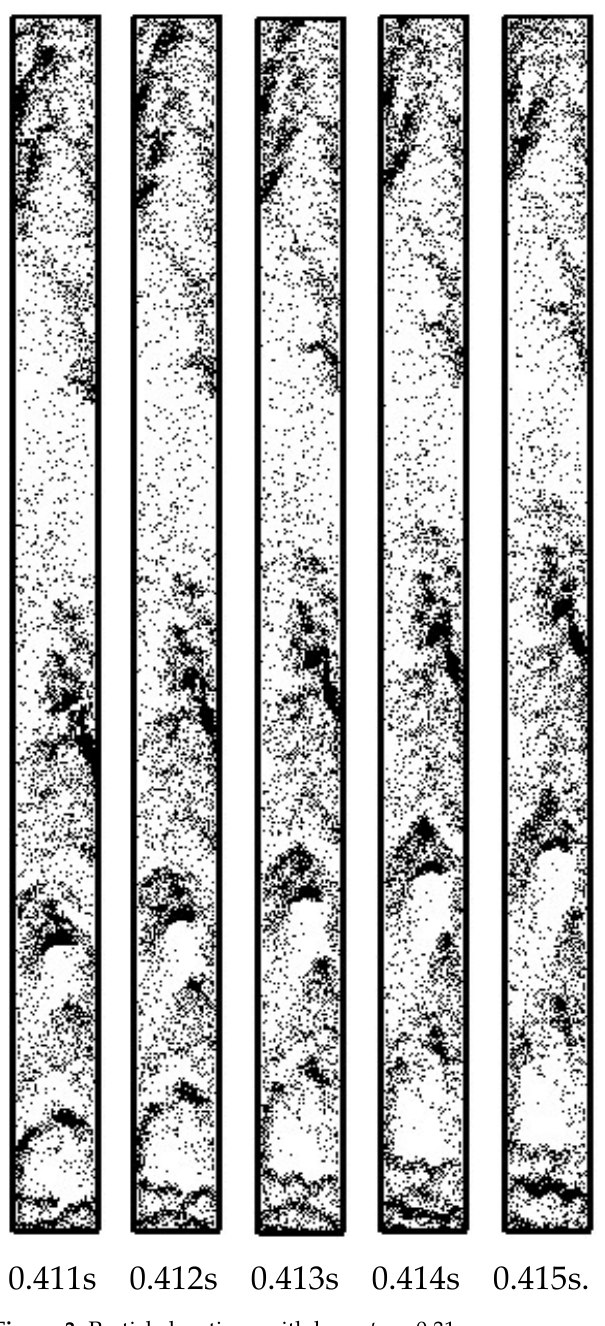
Figure 3. Particle locations with large t r =